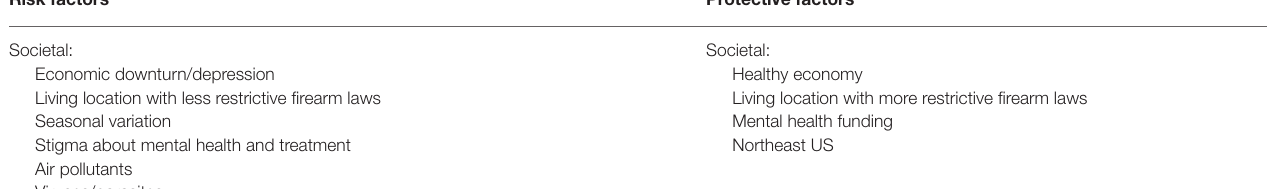
TABLE 1 | Compilation of major suicide risk and protective factors organized by levels of centers for disease control and prevention’s social-ecological model. Risk